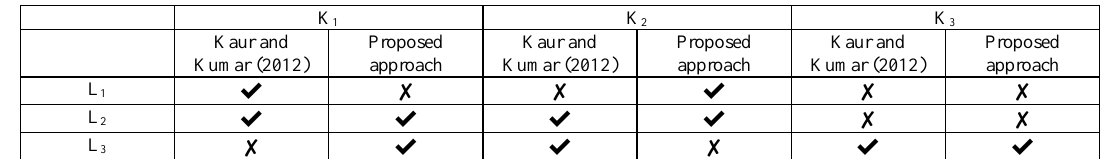
Table 7. Comparison for allocation (Example